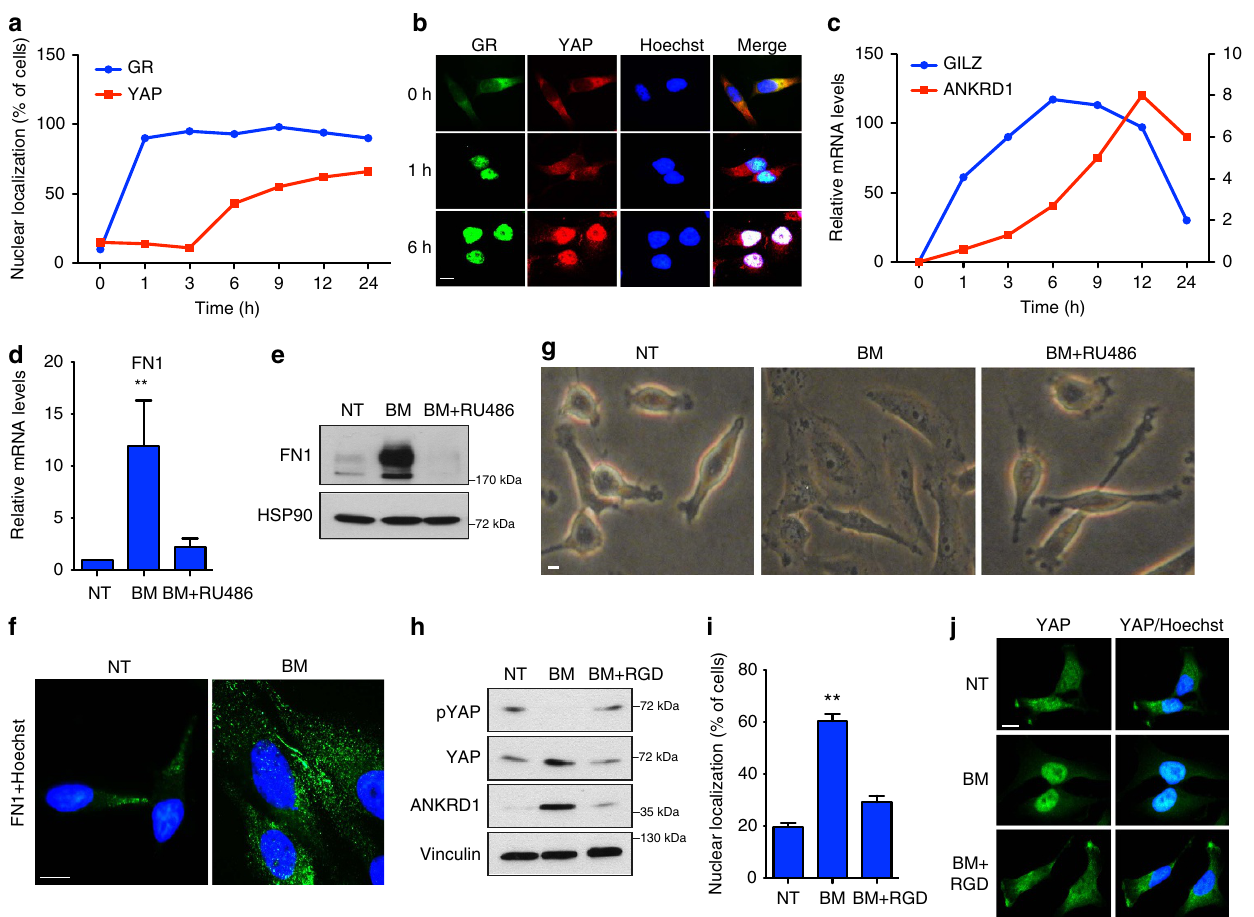
Figure 4 | Glucocorticoid receptor activates YAP by inducing FN1 expression. ( a , b ) Quantification of cells with nuclear YAP ( a ) and representative immunofluorescence ( b ) of serum-starved MDA-MB-231 treated with 1 m M betamethasone (BM) for the indicated times. ( c ) Quantitative PCR with reverse transcription (qRT–PCR) analysis of serum-starved MDA-MB-231 treated with 1 m M BM for the indicated times. Left y axis is relative to GILZ, right y axis is relative to ANKRD1. ( d ) qRT–PCR analysis of serum-starved MDA-MB-231 treated with 1 m M BM alone or in combination with RU486 1 m M for 24h. Error bars represent mean ± s.d., from n ¼ 3 biological replicates. ( e ) MDA-MB-231 cells were treated with BM 1 m M alone or in combination with RU486 1 m M for 24h. Representative blots are shown. Experiment repeated three times. ( f ) MDA-MB-231 cells were serum starved and treated with BM 1 m M for 24h. Extracellular fibronectin was stained by immunofluorescence. Experiment repeated three times. Scale bars, 15 m m. ( g ) Bright-field microscopy image of MDA-MB-231 cells treated with BM 1 m M alone or in combination with RU486 1 m M for 24h. Experiment repeated three times. Scale bars, 15 m m. ( h ) MDA-MB-231 were serum starved and treated with BM 1 m M alone or in combination with RU486 1 m M for 6h. Representative blots are shown. pYAP is phospho-Ser127. Experiment repeated three times. ( i , j ) Quantification ( i ) and representative images ( j ) of MDA-MB-231 cells with nuclear YAP by immunofluorescence. Cells were grown in serum-free medium and treated with BM 1 m M alone or in combination with RGD 500 m gml (cid:2) 1 for 6h. Scale bars, 15 m m. Error bars represent mean ± s.d., from n ¼ 3 biological replicates. * P o 0.05, ** P o 0.01; two-tailed Student’s t -test is used